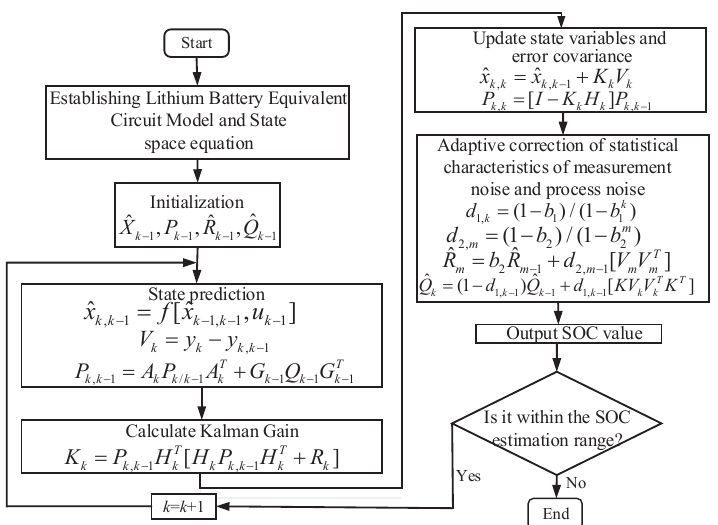
Figure 4. Flowchart of improved SHEKF